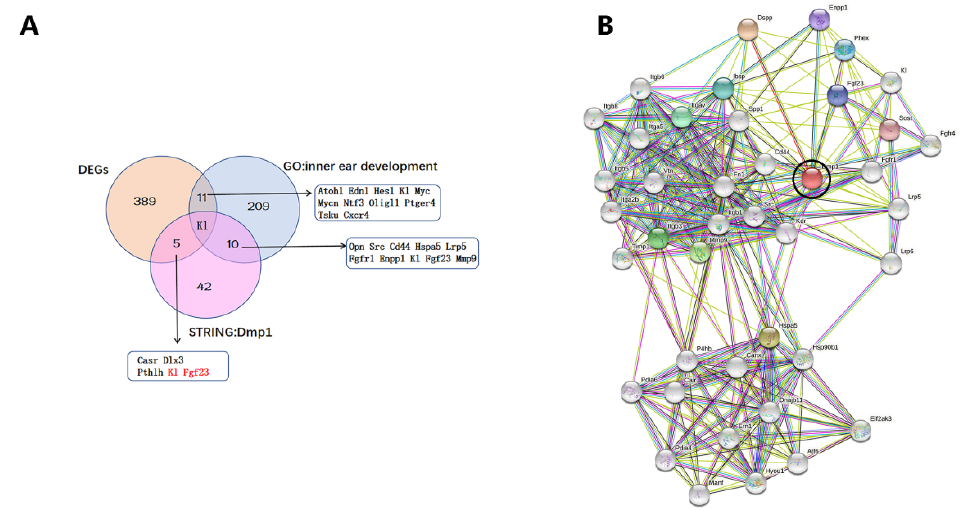
Figure 8. ( A ): Venn diagram among the GO: inner ear development, 389 DEGs and the Dmp1 STRING database. ( B ): STRING database proteins interacting with Dmp1 (black circle in ( B )).